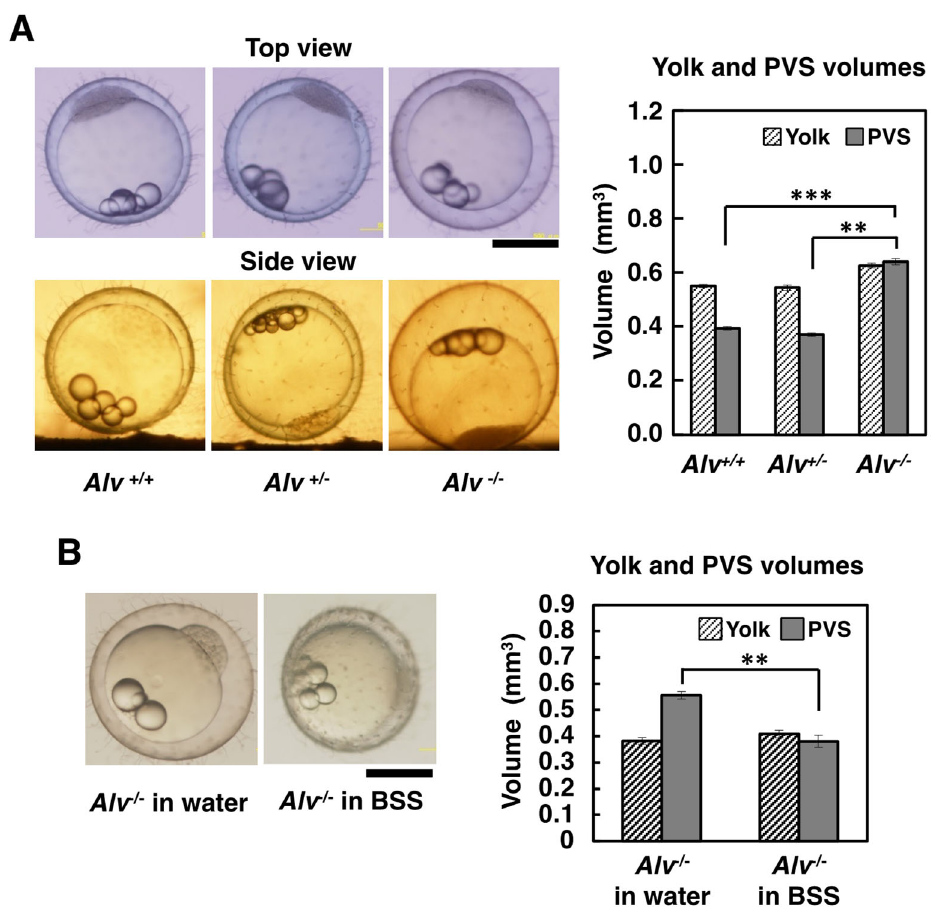
Figure 3. Large egg phenotype of Alv − / − embryos at 4 hpf. ( A ) Photos of 4 hpf embryos of Alv +/+ , Alv +/ − , and Alv − / − genotypes in water from the top (left upper) and side (left lower) views. The scale bar, 0.5 mm. Right , the yolk and PVS volumes, calculated as described in Materials and Methods. The number of embryos tested was 23, 17, and 20 for Alv +/+ , Alv +/ − , and Alv − / − genotypes, respectively. ** p < 0.01, *** p < 0.001; ( B ) The left photos of Alv − / − embryos at 4 hpf in water and BSS. The embryo was fertilized and developed in water (Left) or BSS (Right). The scale bar, 0.5 mm. The right bar graph shows the yolk and PVS volumes. The number of embryos tested was 22. ** p <